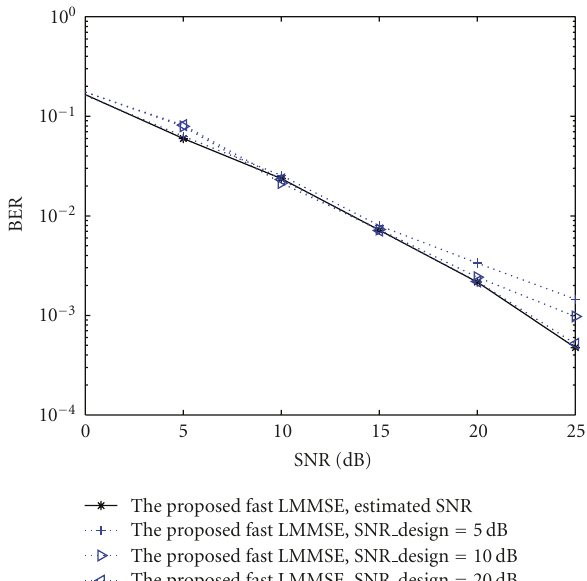
Figure 10: BER comparison between the proposed fast LMMSE channel estimation with estimated SNR and the proposed fast LMMSE channel estimation with designed